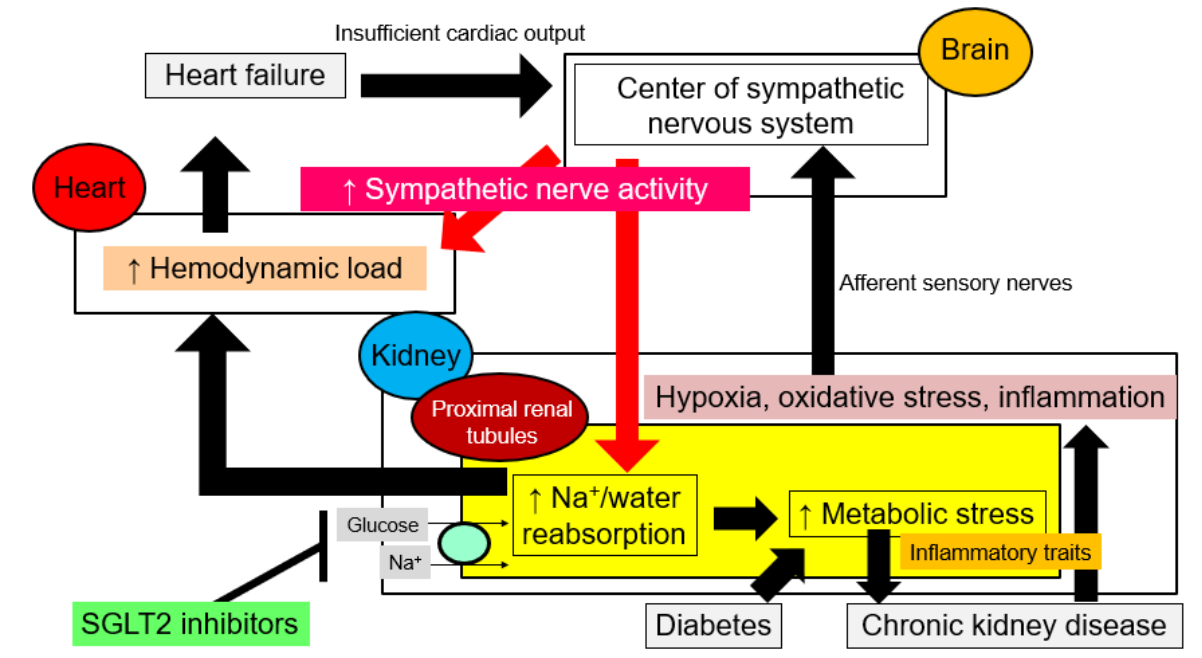
Figure 3. Sodium-glucose co-transporter 2 (SGLT2) inhibitors correct the abnormal hemodynamics of cardiorenal syndrome. The kidneys are central to the continuous activation of sympathetic nervous system activity via cardiorenal coupling. In heart failure, diabetes, and chronic kidney disease, the stress accumulated in the kidneys is transmitted via afferent nerves to the brain, resulting in increased sympathetic activity. In the kidneys, increased sympathetic activity increases Na + and water reabsorption from the proximal tubules, which in turn increases the preload to the heart and exacerbates heart failure. At the same time, it increases the metabolic load on the kidneys, resulting in a further increase in sympathetic activity. SGLT2 inhibitors exert cardiorenal protection by removing renal overload and normalizing sympathetic